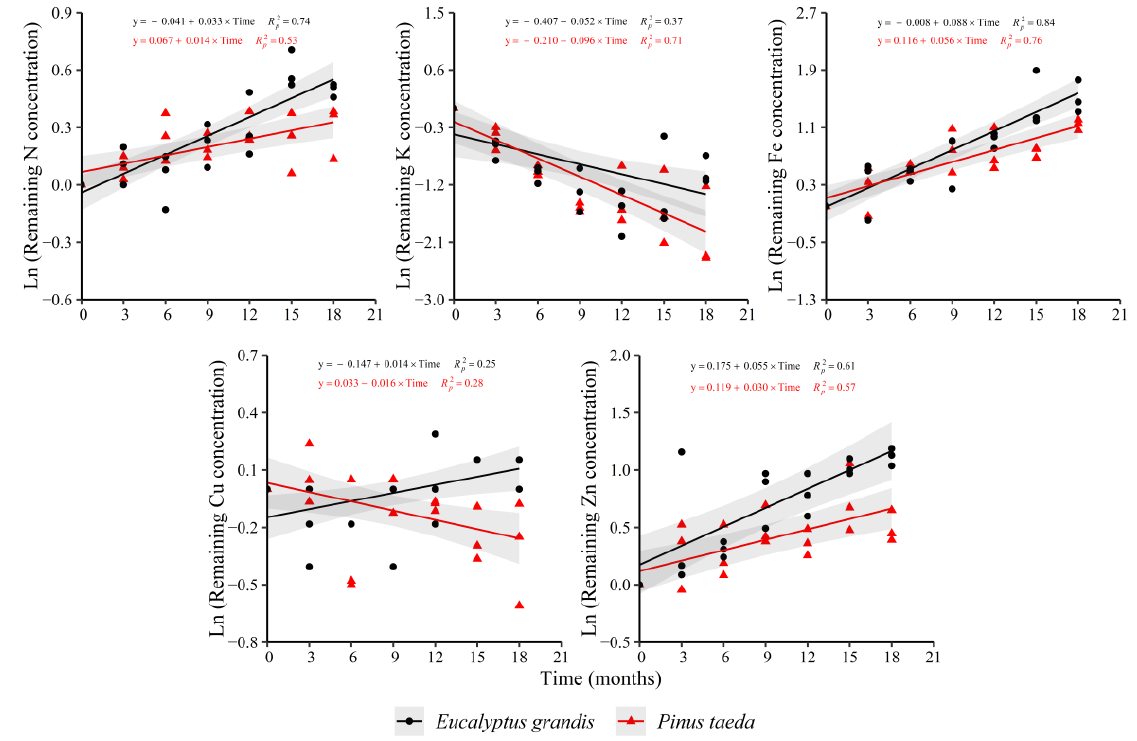
Figure 3. Remaining nutrient concentration of E. grandis (black symbols) and P. taeda (red symbols) litter for the different sampling moments (C2 layer). The gray bands around the models represent the 95% confidence interval.